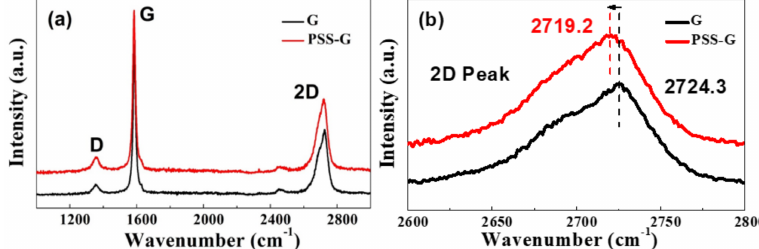
Figure 2. ( a ) Raman spectra of G, PSS-G hybrid; ( b ) the enlarged 2D-band regions; (the black line is for G, the red line is for